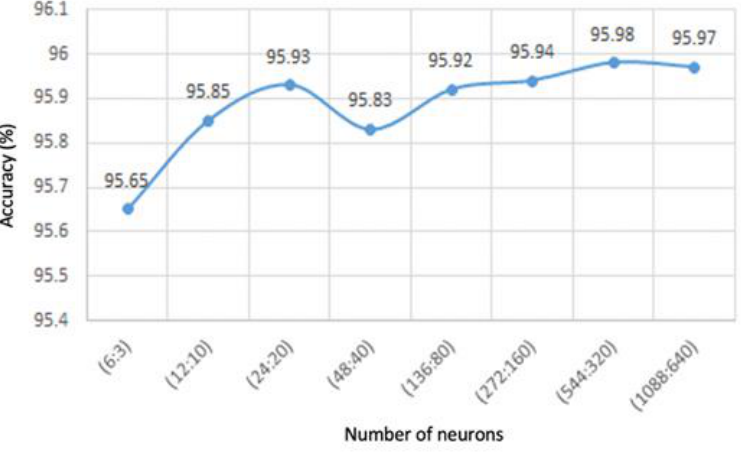
Figure 10. Model accuracy depending on the number of neurons in hidden layers.